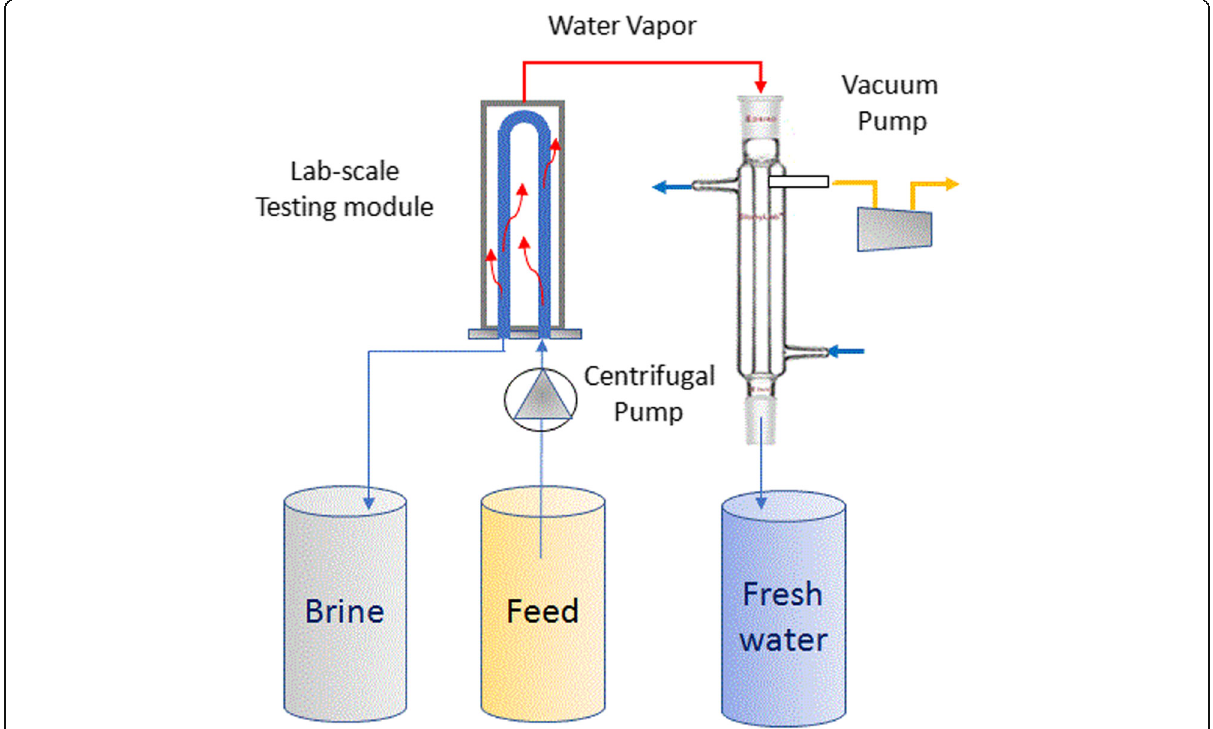
Fig. 6 Schematic diagram for VMD